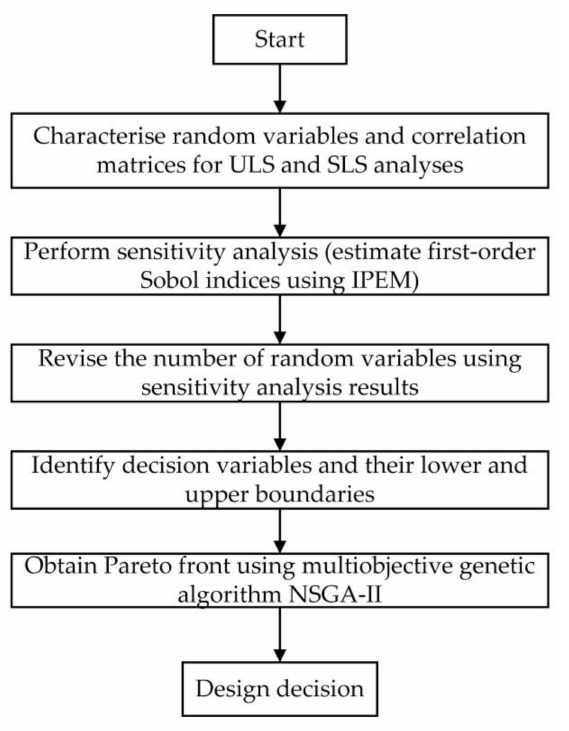
Figure 8. A flowchart of the modified RGD method.